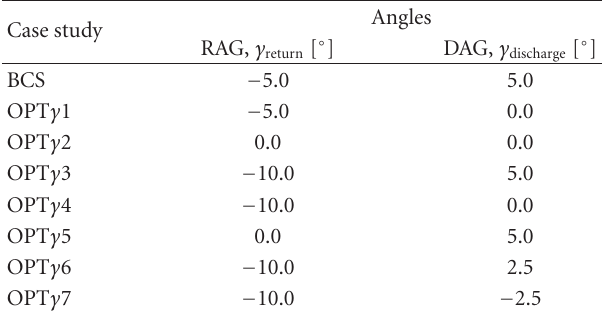
Table 8: DAG and RAG angles—grille angles parametric